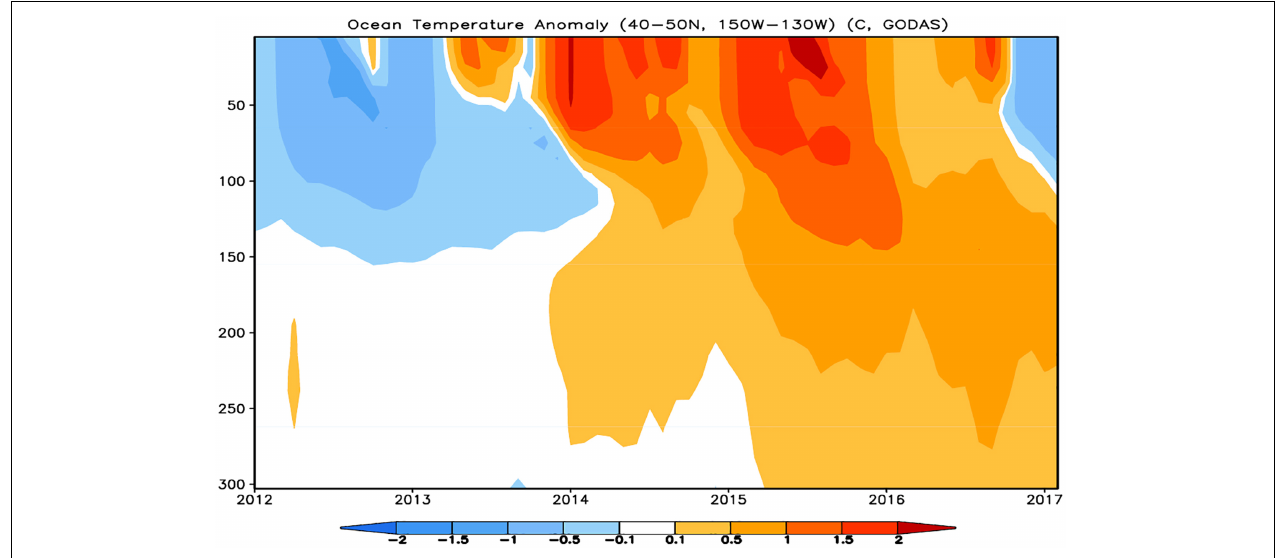
FIGURE 9 | Subsurface temperature anomaly figure from NOAA’s Climate Prediction Center’s monthly briefing, Global Ocean Monitoring: Recent Evolution, Current Status, and Predictions, 9 March 2017 (Climate Prediction Center,